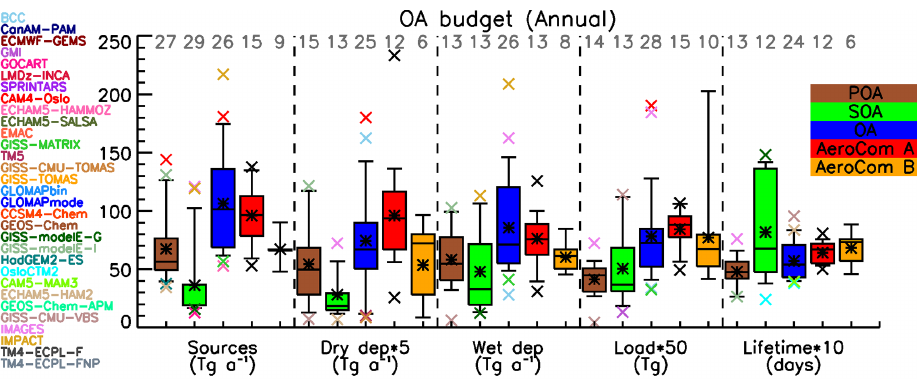
Figure 1. Box and whisker plot for all POA, SOA and OA global budgets and comparison with AeroCom phase I (Textor et al., 2006, 2007) results. The boxes represent the first and third quartile range (50% of the data), the line is the median value, the star is the mean, and the error bars represent the 9/91% of the data. Outliers are presented with x-symbols, with the corresponding color of the model, and the numbers of models participating in each bars statistics are presented with a grey number at the top. The AeroCom phase I outliers are presented with black color, since there is no direct correspondence with the models that participate in the present study. Bar colors are POA (brown), SOA (green), OA (blue), AeroCom A (red; Textor et al., 2006), and AeroCom B (orange; Textor et al.,